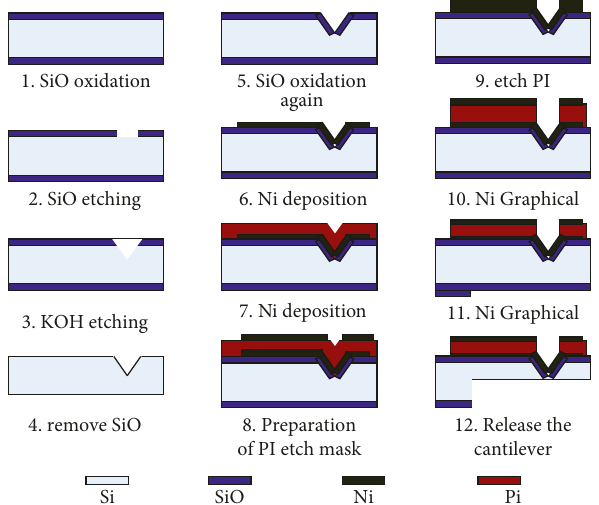
Figure 3: The general flow of the maskless etching process in the microplasma